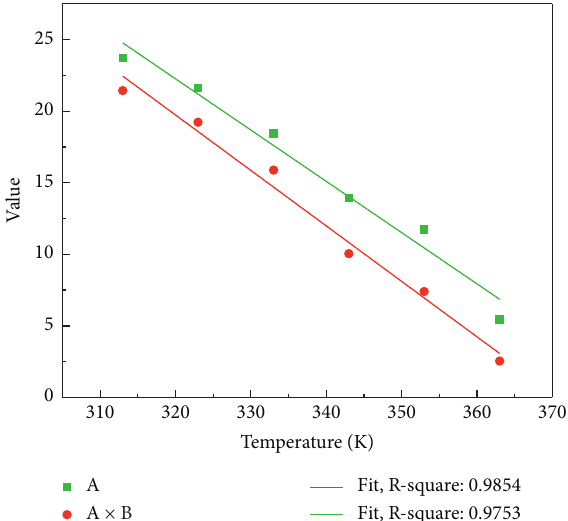
Figure 4: Fitting curves of A and A × B at different temperatures in equation (3).